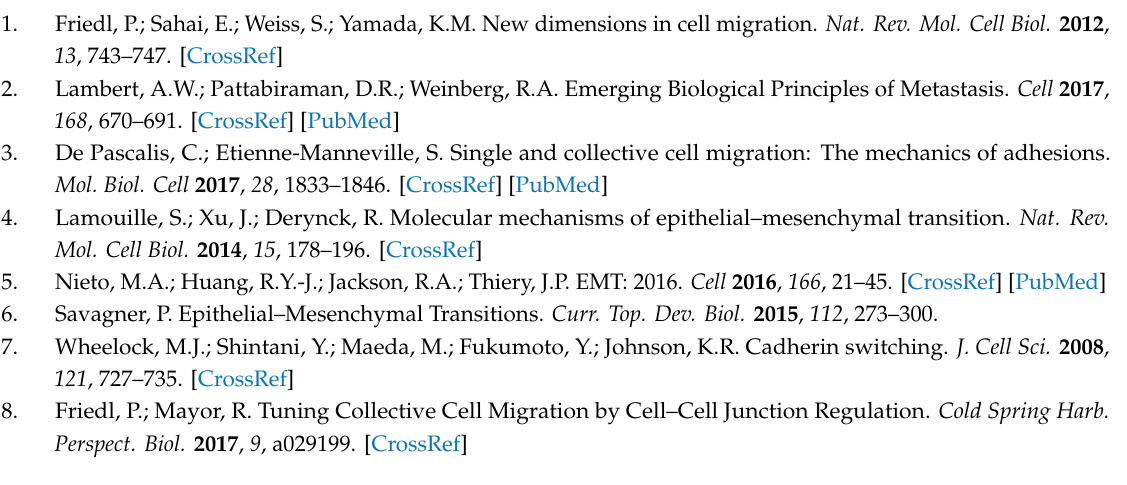
Figure S1. Phenotypic characterization of fibroblasts. Figure S2: Clinical outcome associated with the E-cadherin expression in head and neck SCCs and other epithelial cancer